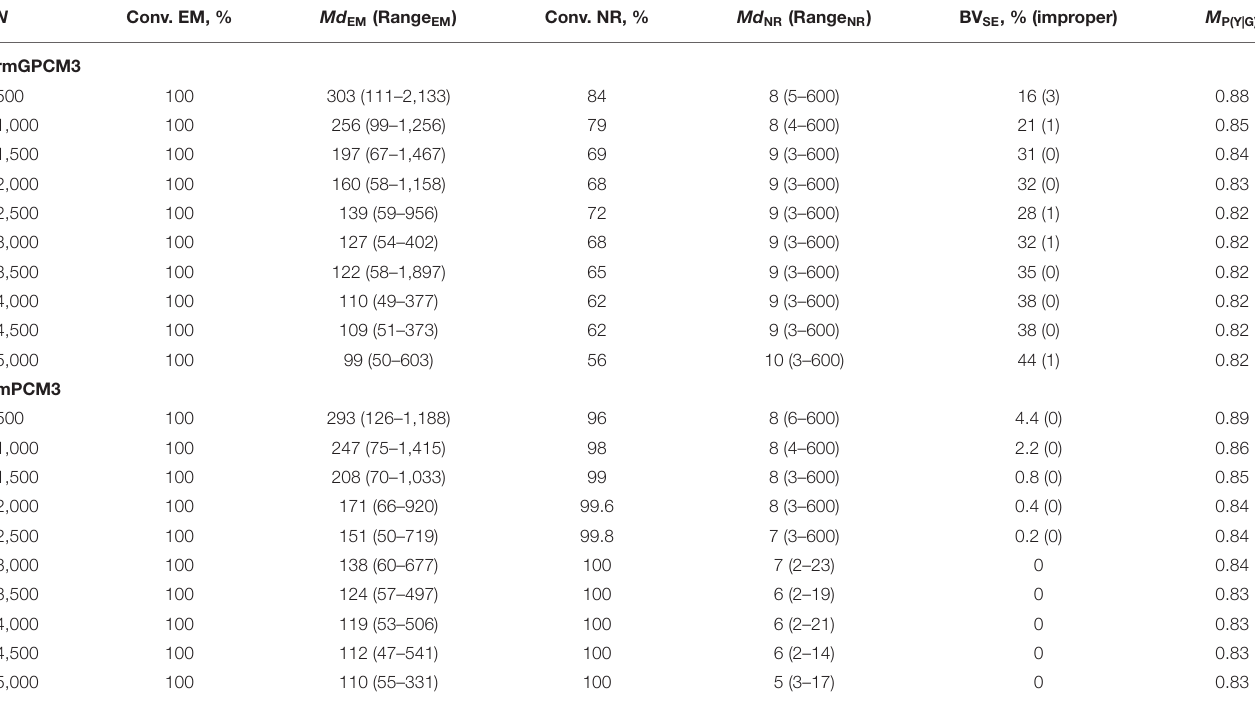
TABLE 3 | Convergence rates of the EM algorithm and the Newton-Raphson algorithm, number of required iterations, occurrence of boundary values and improper solution, and mean classification probability for the rmGPCM-3 and the mPCM-3 under the condition of a true three-class mixture and a 5-item scale with 11 categories.